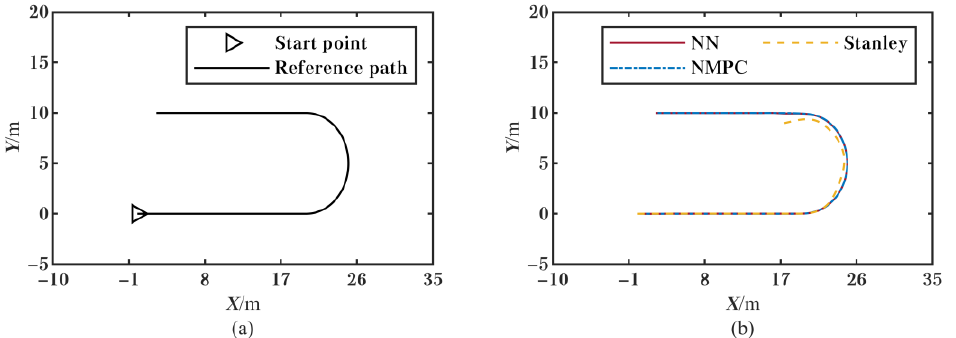
Figure 4. The reference path and the trajectory of the comparison simulation: ( a ) the reference path; ( b ) the trajectory.